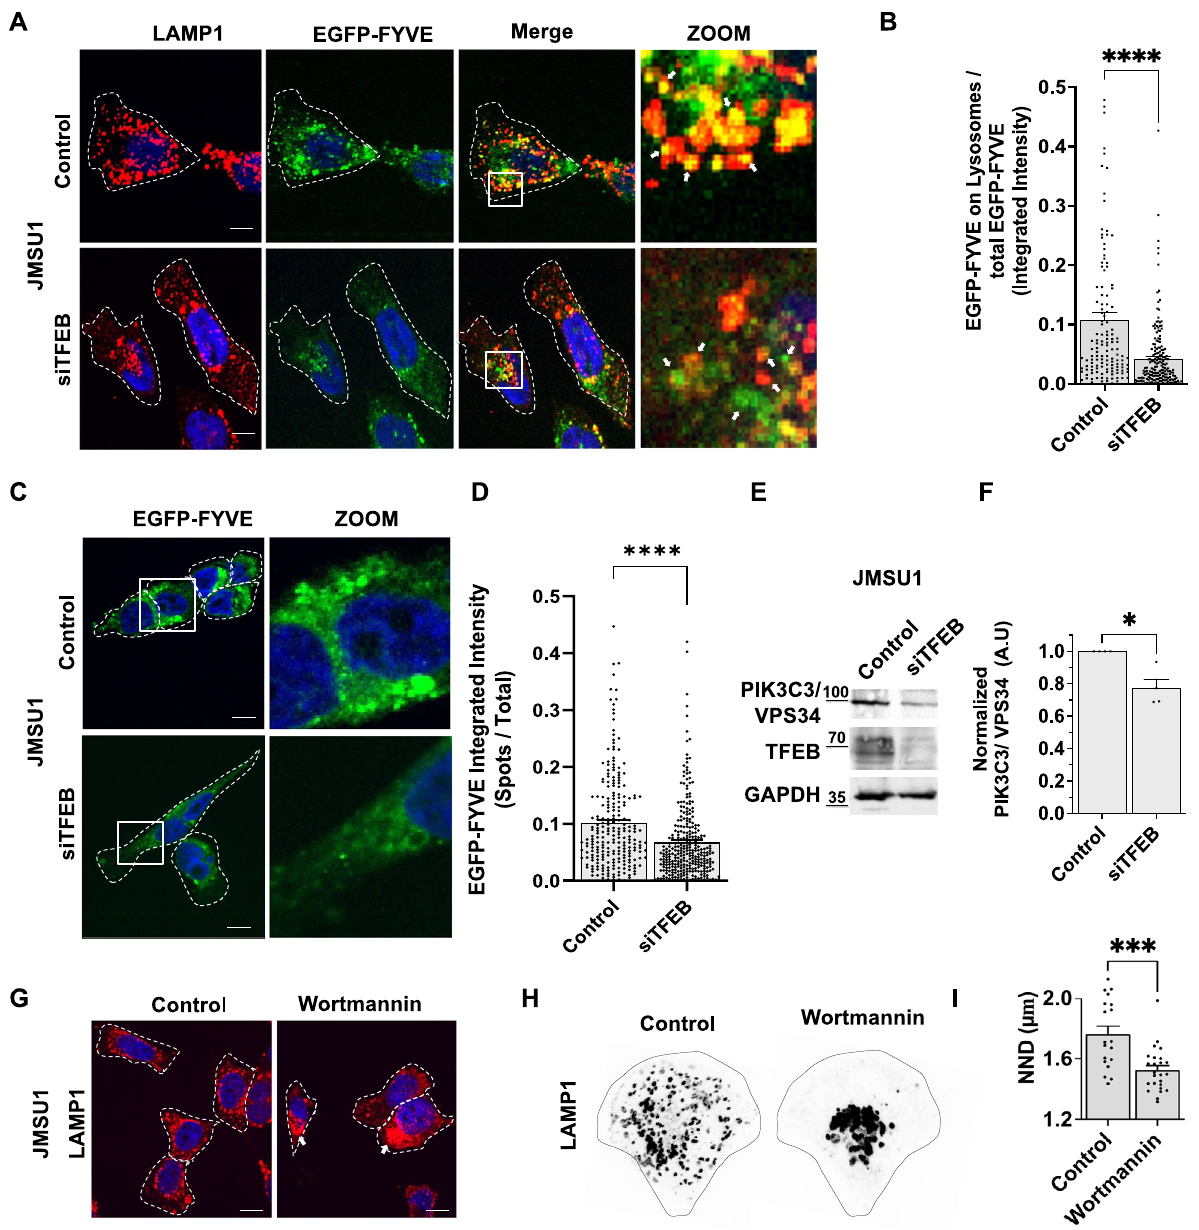
Fig. 5 TFEB regulates phosphatidylinositol-3-phosphate levels on endomembranes in bladder cancer cells. A Immuno fl uorescence staining of the lysosomal-associated membrane protein 1 (LAMP1/CD107a) (red) in control (siLUC) and siTFEB (72 h) treated JMSU1 cells transfected with EGFP-FYVE (green). Zoom shows the merged images of LAMP1 and EGFP-FYVE in white box. White arrow shows the colocalization between LAMP1 and EGFP-FYVE. Scale bars equal 10 µ m. B Quanti fi cation of EGFP-FYVE integrated intensity on lysosomes normalized to total cellular EGFP-FYVE, in 132 siLUC and 188 siTFEB treated JMSU1 cells; **** p < 0.0001 in a Mann – Whitney U test, error bars are SEM. C Representative images of control (siLUC) and siTFEB (72 h) treated JMSU1 cells expressing EGFP-FYVE. Zoom shows EGFP-FYVE in white box. Scale bars equal 15 µ m. D Quanti fi cation of EGFP-FYVE integrated intensity on segmented spots normalized to corresponding total cellular EGFP-FYVE, in 176 siLUC and 244 siTFEB JMSU1 cells; **** p < 0.0001 in a Mann – Whitney U test, error bars are SEM. E Western blot analysis of PIK3C3/ VPS34 in JMSU1 cells in control (siLUC) and siTFEB (72 h) treatment conditions. F Western blot quanti fi cation of PIK3C3/ VPS34 in JMSU1 cells in control (siLUC) and siTFEB (72 h) treatment conditions from n = 4 experiments. * p < 0.05 in a t test, Error bars are SD. G Immuno fl uorescence staining of LAMP1 in control (DMSO) and wortmannin (1 µ M) treated JMSU1 cells. White arrows show the perinuclear clustering of lysosomes. H Representative images of lysosomes visualized by immuno fl uorescence staining against LAMP1 in micropatterned control and wortmannin (1 µ M) treated JMSU1 cells. I Nearest neighbor distance (NND in µ m) between lysosomes in micropatterned in control ( n = 19) and wortmannin ( n = 25) JMSU1 cells; *** p < 0.001 p value in a Mann – Whitney U test, error bars are has been shown to upregulate the lysosomal transmembrane regulate PtdIns3P production in bladder cancer cell lines that protein TMEM55B resulting in central clustering of lysosomes result in TFEB-dependent and independent lysosome move- through its interaction with dynein adapter JIP4 26 . On the other ments. Other studies have reported that TFEB regulated lysosome hand, TFEB overexpression has been also shown to regulate positioning 26,48 . For instance, activation of TFEB in HeLa cells